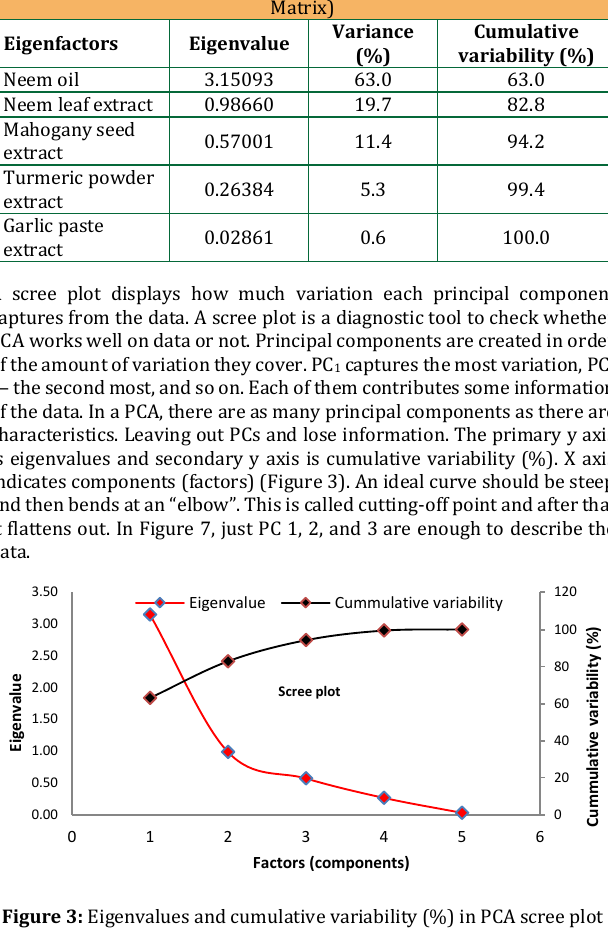
Figure 3: Eigenvalues and cumulative variability (%) in PCA scree plot